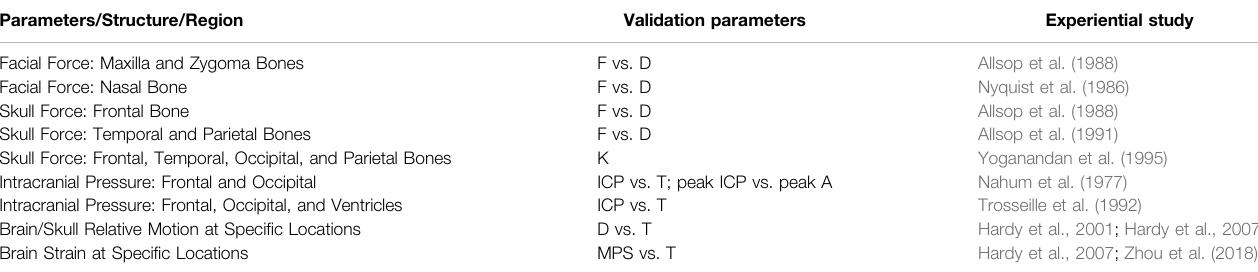
TABLE 3 | Cadaver head impact cases used for the model